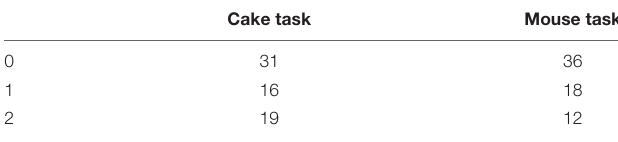
Cake task Mouse